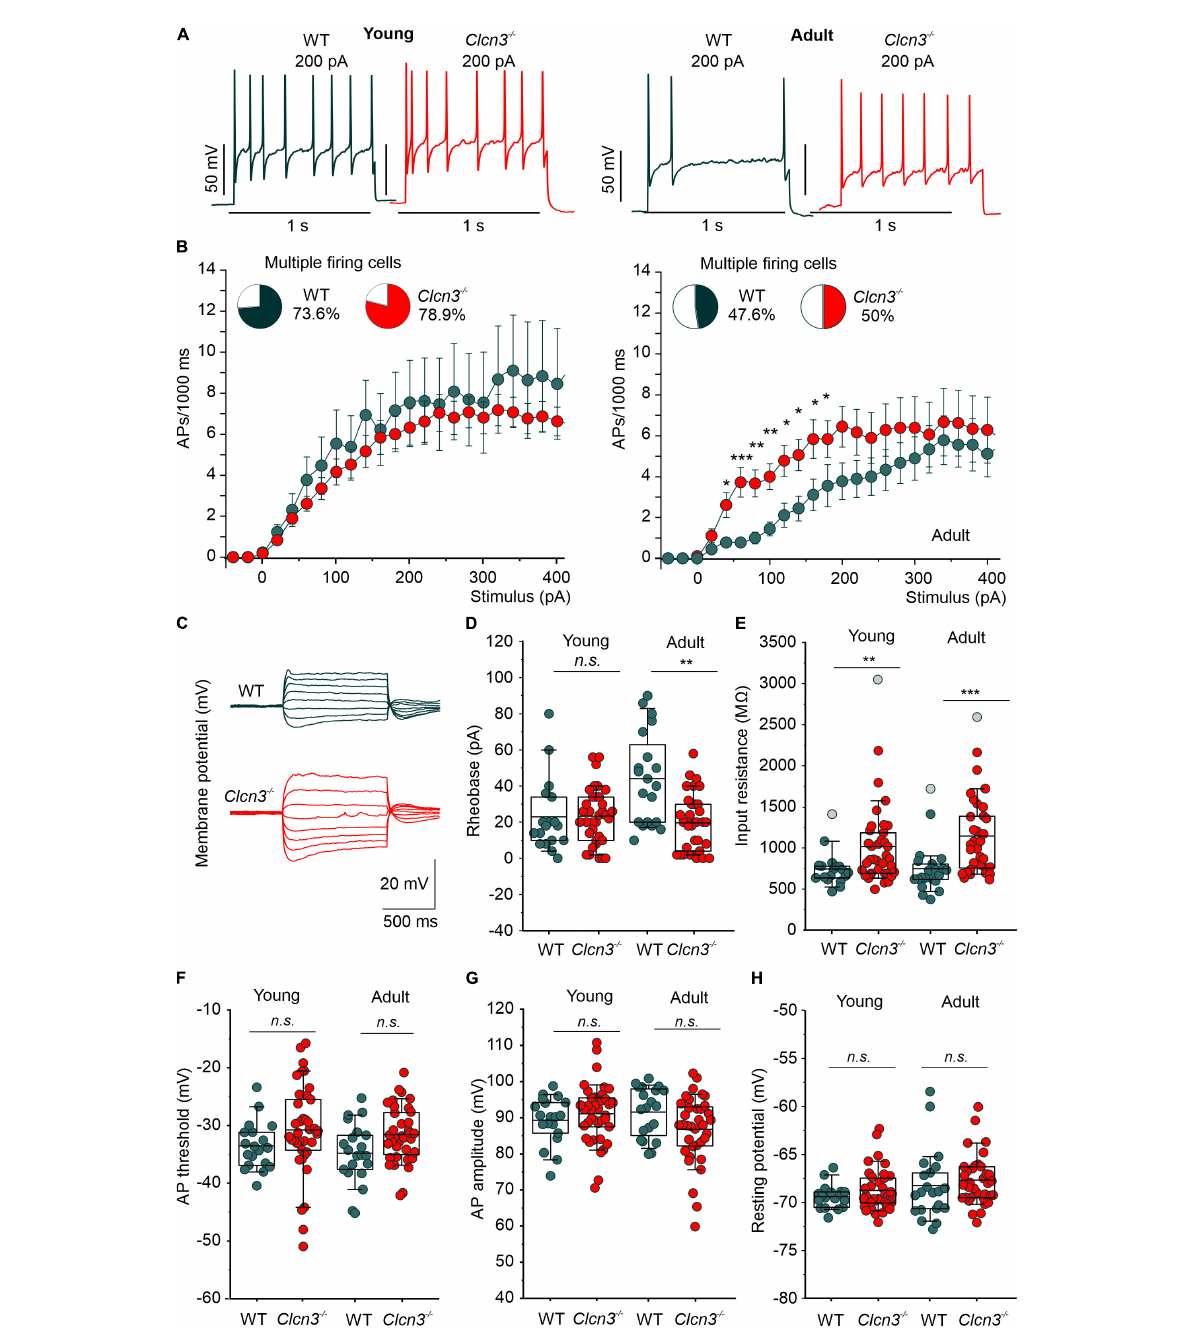
FIGURE2 Change in excitability of dorsal root ganglion (DRG) neurons from young and adult Clcn3 − / − animals. (A) Representative traces of action potentials (APs) elicited by a current injection of 200 pA in young (left) and adult (right) wild type (WT) (green) and Clcn3 − / − (red) neurons. (B) Average firing frequencies from young and adult Clcn3 − / − and WT dorsal root ganglion (DRG) neurons. Insets show the percentage of multiple firing neurons for each condition. (C) Representative current responses of control (green) and a Clcn3 − / − (red) neuron to hyperpolarizing and depolarizing current pulses. (D) Current threshold necessary to elicit the first action potential (AP; rheobase) in young and adult Clcn3 − / − and WT DRG neurons. (E) Average input resistances of DRG neurons from P21 and P60 mice. Symbols in gray are outliers values included in the analysis. (F) AP thresholds, (G) amplitudes, and (H) RMP for young and adult neurons. Data were collected from young WT ( n = 19 cells from four animals) and Clcn3 − / − ( n = 38 cells from four animals) and adult WT ( n = 21 cells from seven animals) and Clcn3 − / − ( n = 36 cells from six animals) cells. Statistical significance levels are * p < 0.05, ** p < 0.01, *** p < 0.001, n.s., not significant. A two-way ANOVA or Kruskal–Wallis ANOVA was used to compare the age and phenotype of the two groups. The Tukey post hoc test was used for pairwise comparisons. Data are presented as the mean ± SEM. In boxplots, boxes indicate the upper and lower quartiles, and whiskers the upper and lower 90